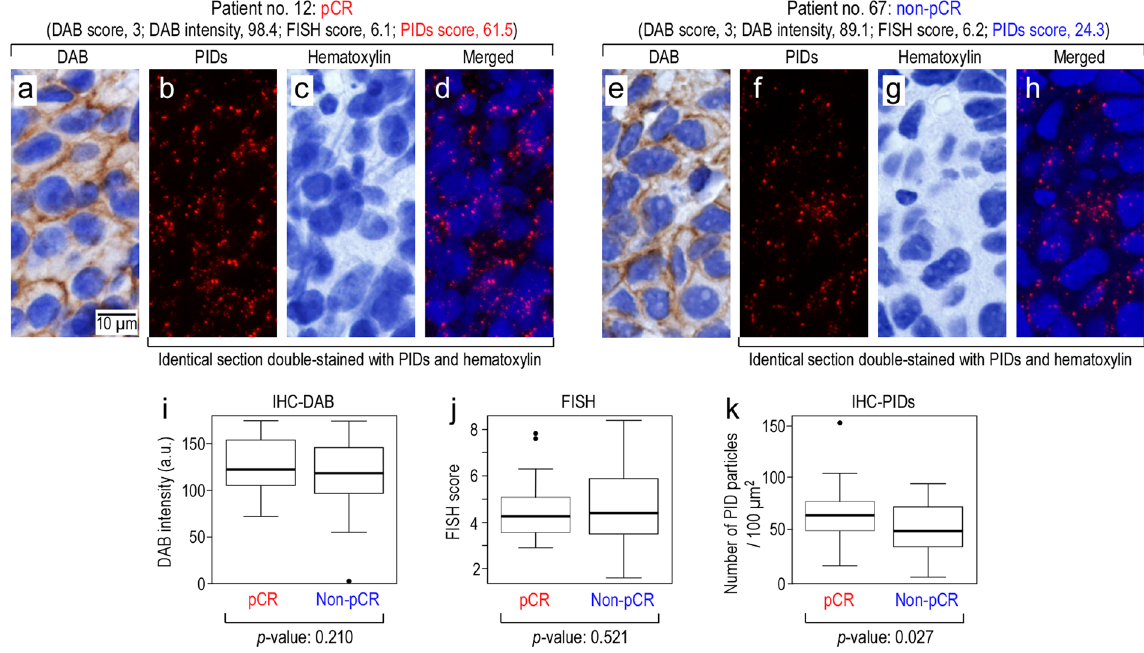
Figure 5. Categorization of the response to anticancer drug therapy using IHC-PIDs. We acquired tissues from pre-chemotherapy biopsies from 74 HER2-positive patients (Supplementary Table 1). These tissues were tested with IHC-DAB ( a , e ), FISH or IHC-PIDs ( b – d , f – h ). ( a – d ) and ( e - h ) show typical samples of patients 12 and 67, respectively, as numbered in Supplementary Table 1. Both tissues have a score of 3 in HER2 testing by IHC- DAB and a FISH score of approximately 6. DAB intensity of patient no. 12 (score, 98.4) and no. 67 (score, 89.1) analyzed using Aperio image analysis were similar ( a , e ). However, patient no. 12 had a pCR, and patient no. 67 had a non-pCR. ( a ), ( b – d ), ( e ) and ( f – h ) represent different sections. ( b – d ) and ( f – h ) are identical sections double-stained with PIDs and hematoxylin, respectively. The images of all tissues samples are displayed at the same magnification. Bar, 10 μ m. These staining results show that IHC-DAB and FISH could not distinguish between pCR (n = 34) and non-pCR (n = 40). The p -values of the t -tests for IHC-DAB and FISH were 0.210 ( i , boxplot) and 0.521 ( j , boxplot), respectively, and did not indicate significant differences. By contrast, the p -value of the t -test for the IHC-PIDs was 0.027, and this imaging clearly distinguished pCR (n = 34) from non-pCR (n = 40) ( k ,